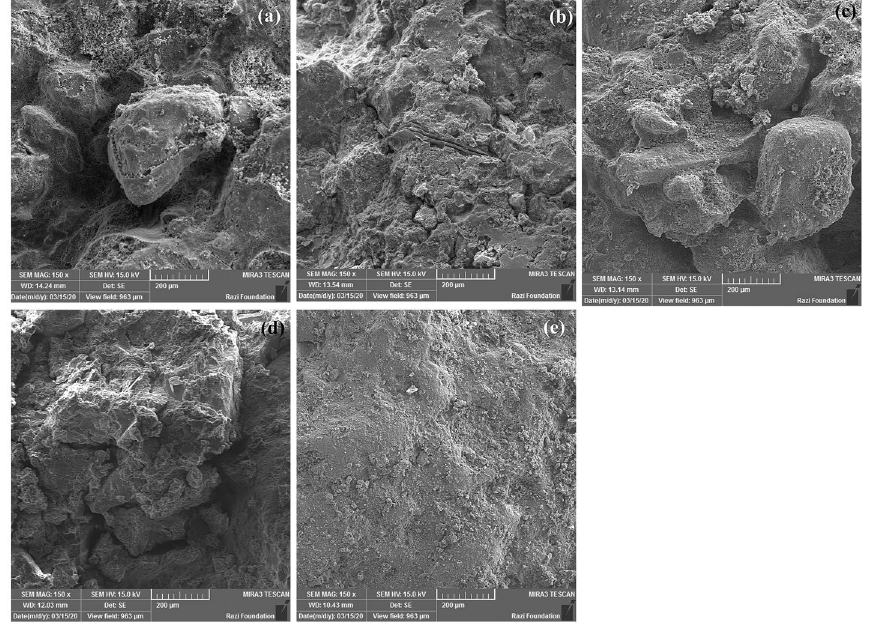
Fig. 18 The SEM images of mixtures with cement of 5% and different fine additives under 150 magnification: a S-C5 mixture, b ) S-C5-B10 mixture, c S-C5-K10 mixture, d S-C5-B30 mixture, e S-C5-K30 ×